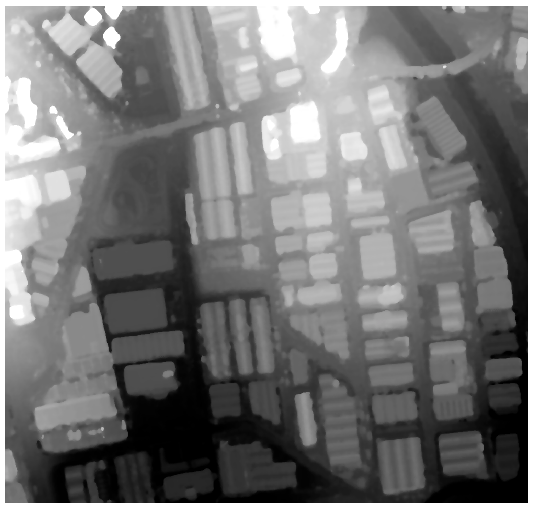
Figure 12. Mesh-based DSM.